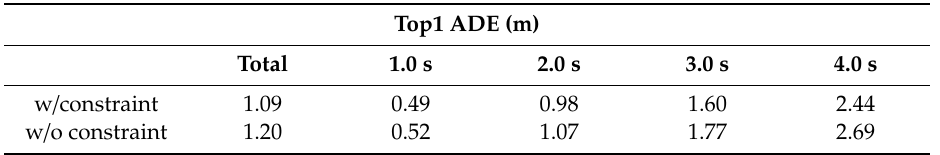
Table 4. Comparison of the Top1 ADE values corresponding to the prediction with and without constraints at a merging section .